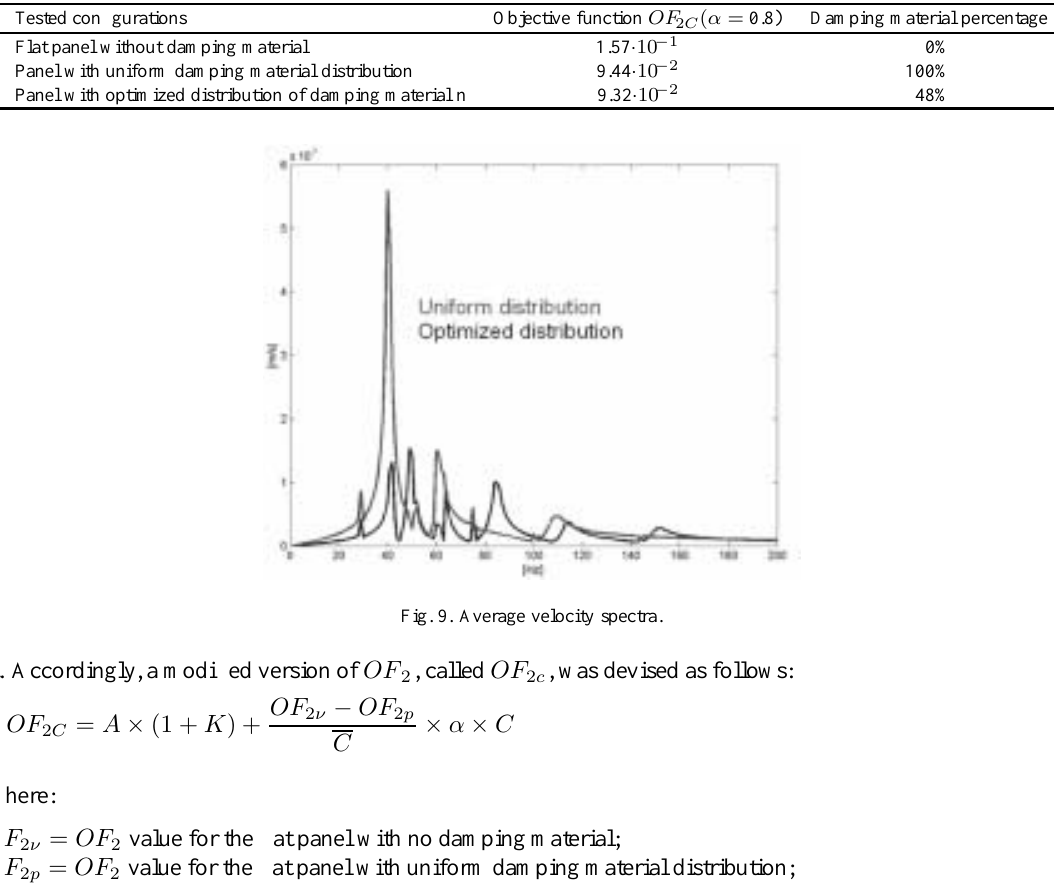
Table 3 OF 2 c values for three damping material distributions ( α = 0.8)